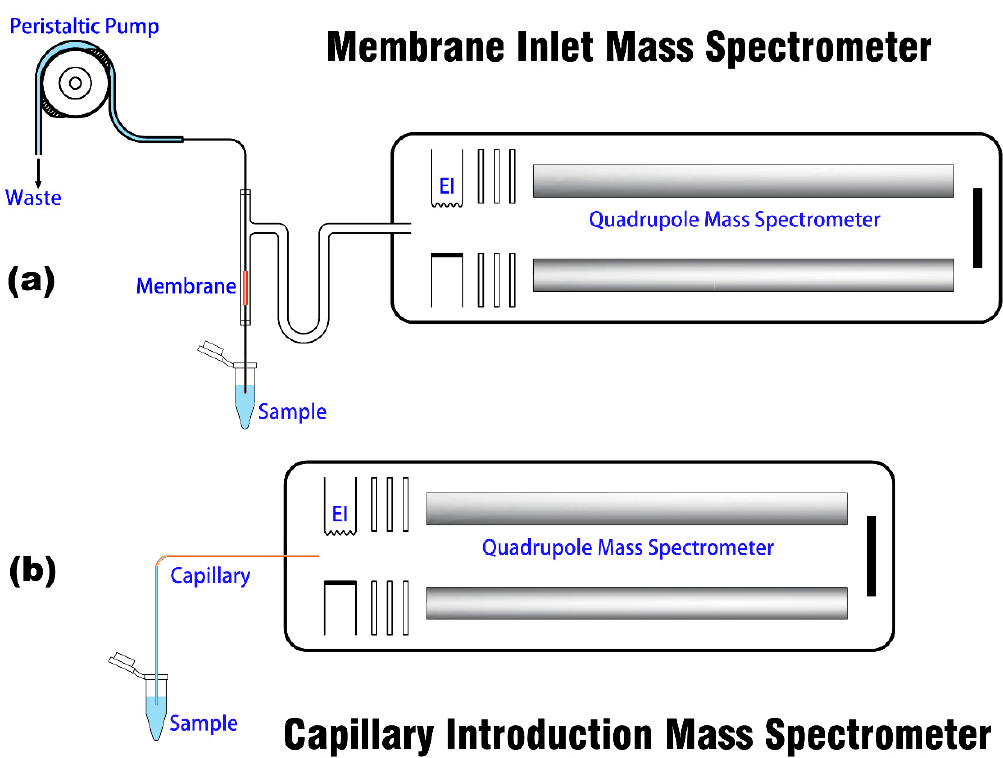
Figure 1. Structural diagrams of ( a ) MIMS and ( b ) CIMS.